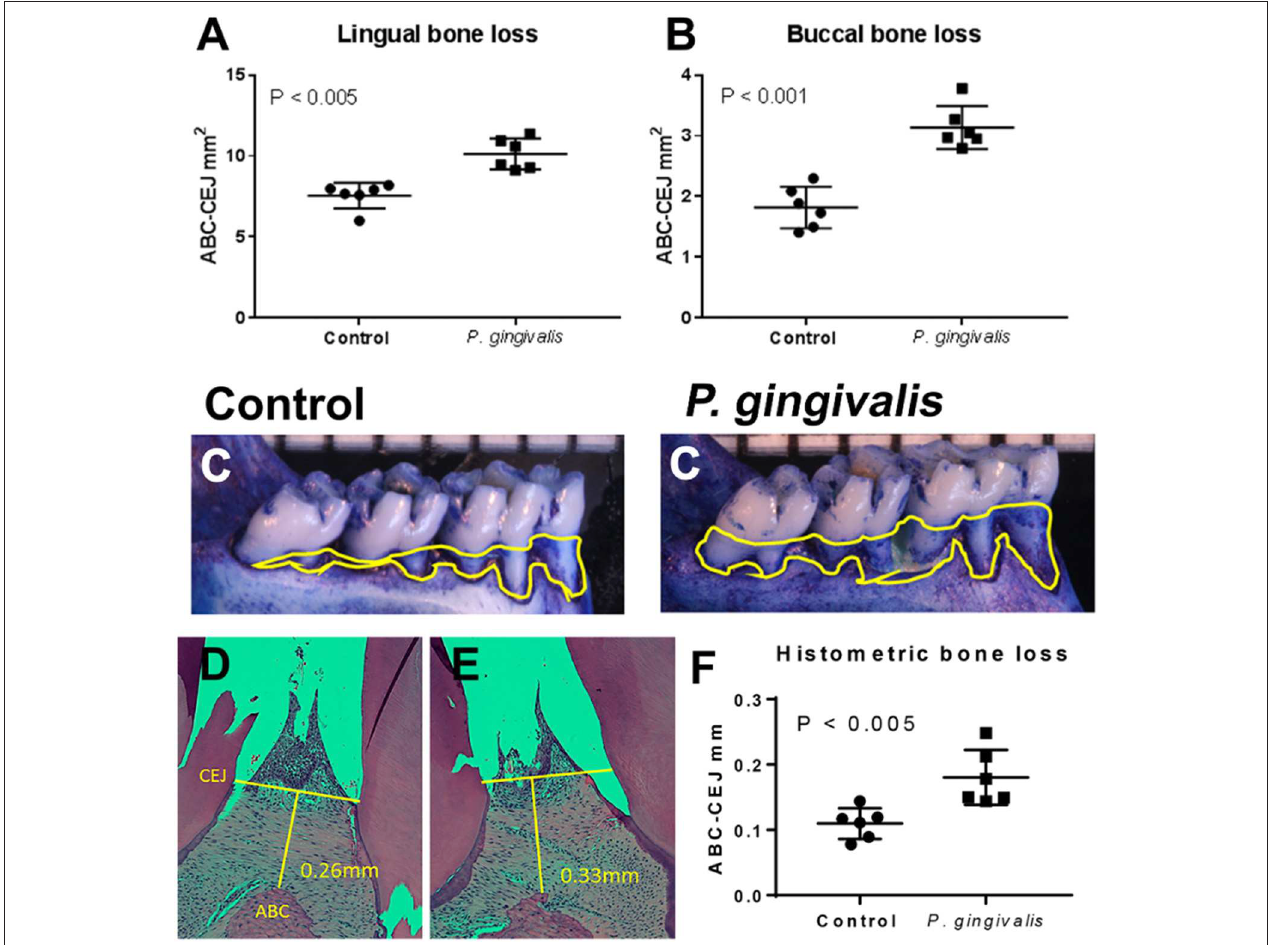
FIGURE 1 | All P. gingivalis inoculated animals had significantly greater alveolar bone loss than aged-matched sham-inoculated controls (baseline) confirming that these animals had periodontal disease. Morphometric assessment of mandibular and maxillary bone loss in pregnant control and PG-inoculated rats. Values in each graph represent the extent of horizontal bone loss, labeled as CEJ-ABC area measurements (mm 2 ), on the lingual (A) and buccal (B) sides from each mandible. (C) Representative images of the lingual aspect of the rat mandible illustrating the extent of horizontal bone loss. Yellow lines demarcate the CEJ-ABC junction that was used to determine extent of bone loss. Representative images of maxillary interdental papilla from control (D) and PG-inoculated rats (E) demonstrating how CEJ and ABC measurements were taken for histomorphometry (F) . Bars in all graphs show the mean ± SD. Data were analyzed by unpaired student’s t test.